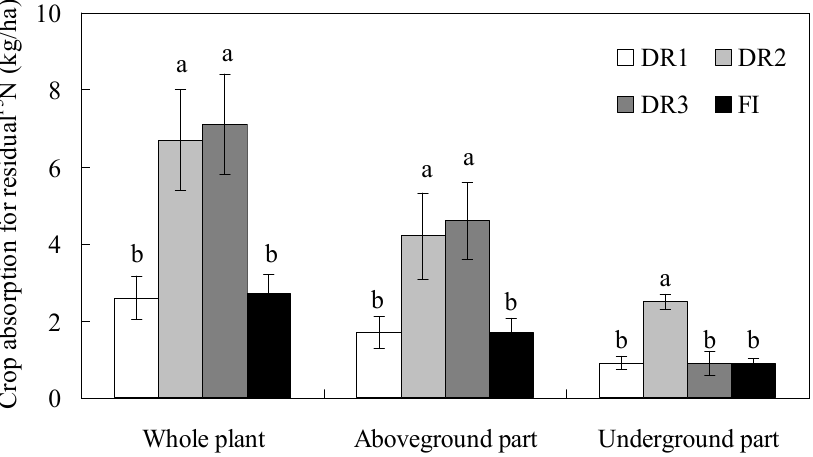
Figure 4. The plant absorbed 15 N and its distribution in different lettuce organs (DR1, DR2, and DR3 mean the lower irrigation limits of 75%, 65%, and 55% accounting for the field capacity, separately. FI represents furrow irrigation treatment using the same irrigation regime as DR2. The data in the Figure are mean ± SD. The different letters (a, b) indicate significant differences at the level of 0.05 according to Duncan’s multiple range test).